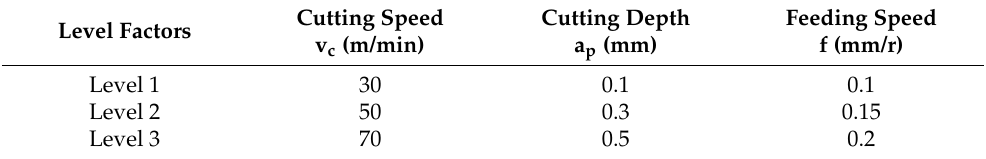
Table 3. Orthogonal factor levels.